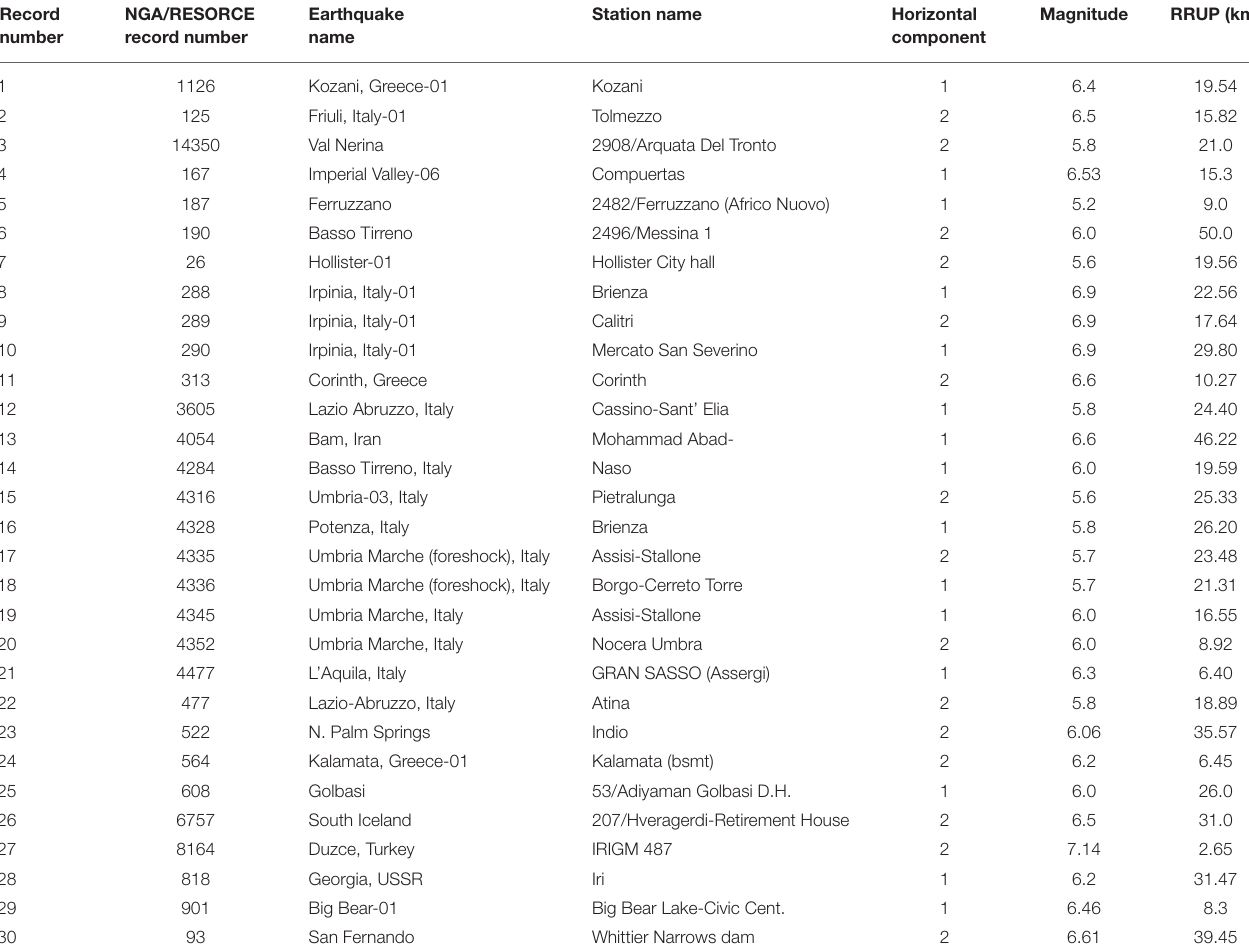
TABLE 1 | The set of the considered